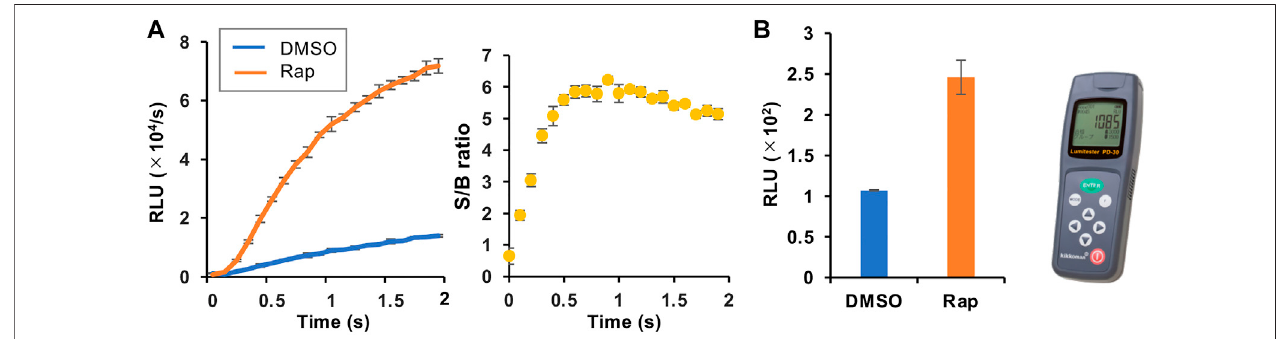
FIGURE 3 | Optimization of the assay condition. (A) FlimPIA under the optimized condition. (B) Measurement using the Lumitester PD-30. Error bar: ± 1 × SD ( n (cid:2) 3). Ppy Donor (50 nM) and LlL Acceptor (50 nM) were reacted with LH 2 (33 μ M) and ATP (1.25 mM) with/without rapamycin (Rap, 50 nM) in the presence of 1 mM of coenzyme A.